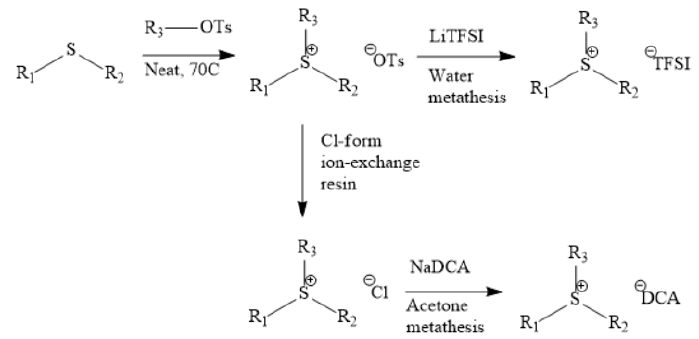
Figure 4. Improved synthetic strategy to prepare DCA-based ILs [33].